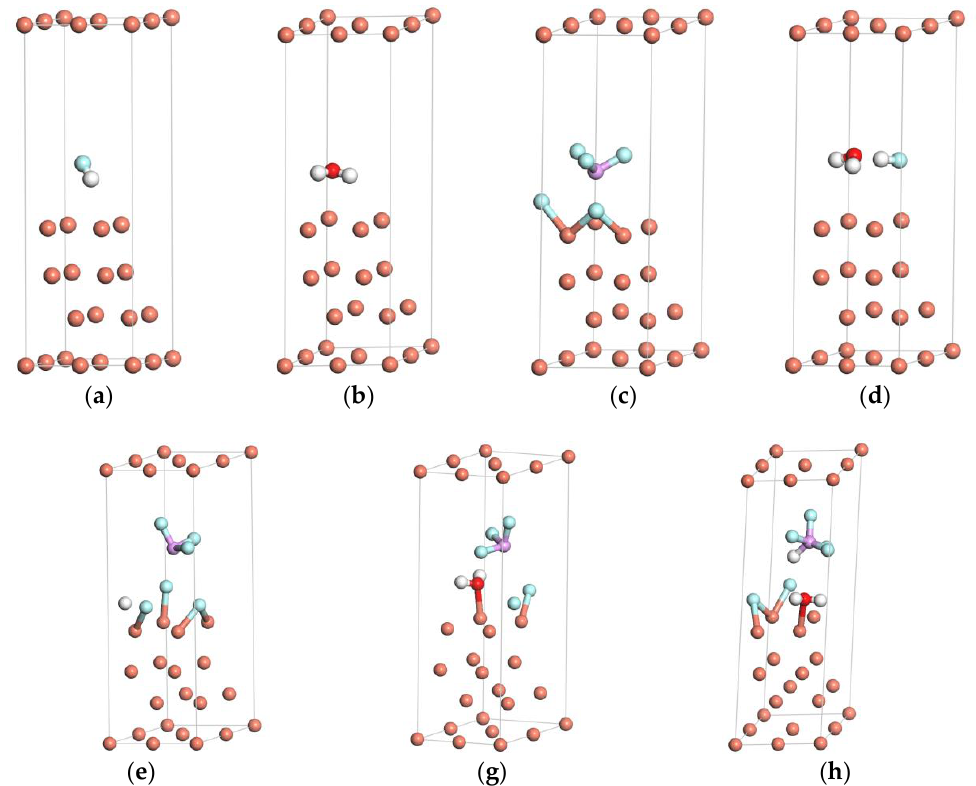
Figure 2. Schematic drawings of HF, H 2 O, and PF 5 adsorbed on the Cu(111) surface after structure optimization: ( a ) HF, ( b ) H 2 O, ( c ) PF 5 , ( d ) HF and H 2 O, ( e ) HF and PF 5 , ( f ) H 2 O and PF 5 , and ( g ) HF, H 2 O, and PF 5 .